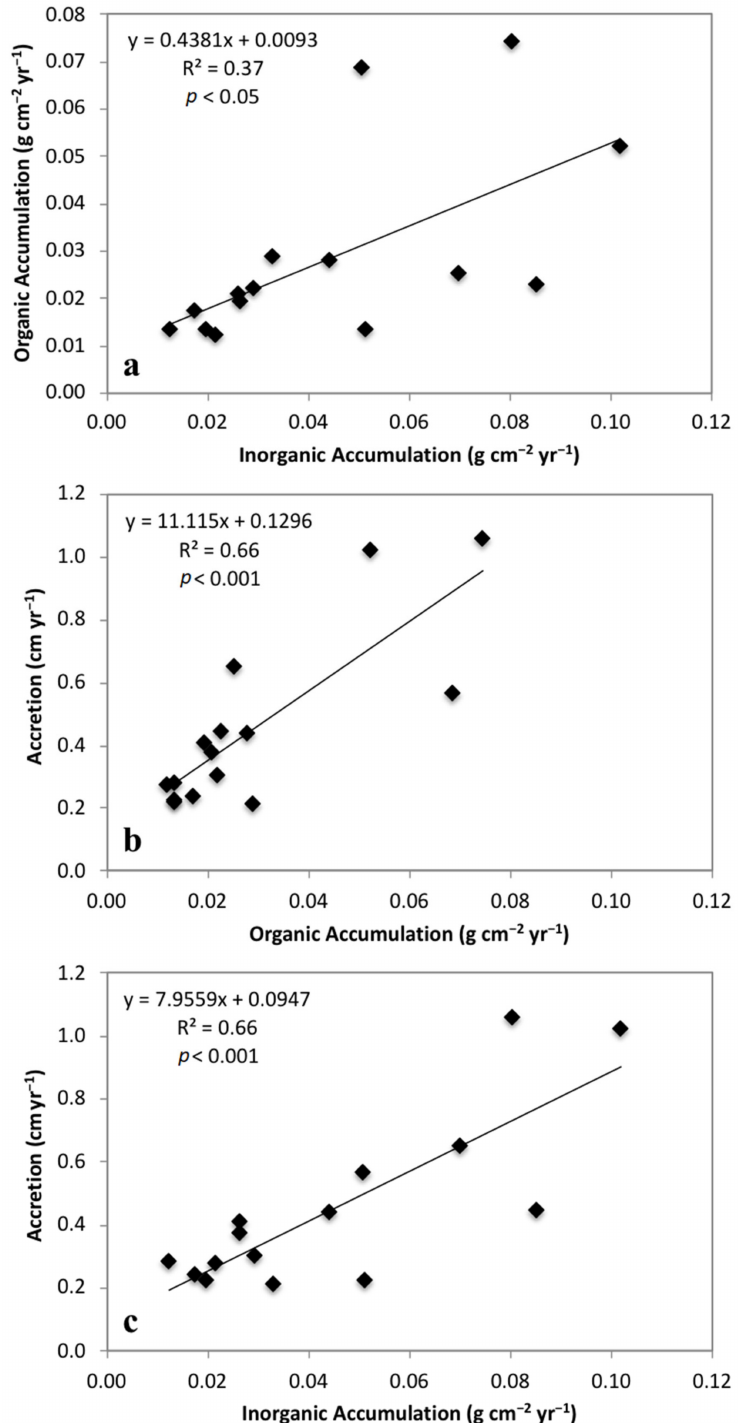
Figure 6. Relationships between ( a ) organic accumulation (g cm − 2 yr − 1 ) and inorganic accumulation (g cm − 2 yr − 1 ); ( b ) accretion (cm yr − 1 ) and organic accumulation (g cm − 2 yr − 1 ); and ( c ) accretion (cm yr − 1 ) and inorganic accumulation (g cm − 2 yr − 1 ) for subsites along the Nanticoke